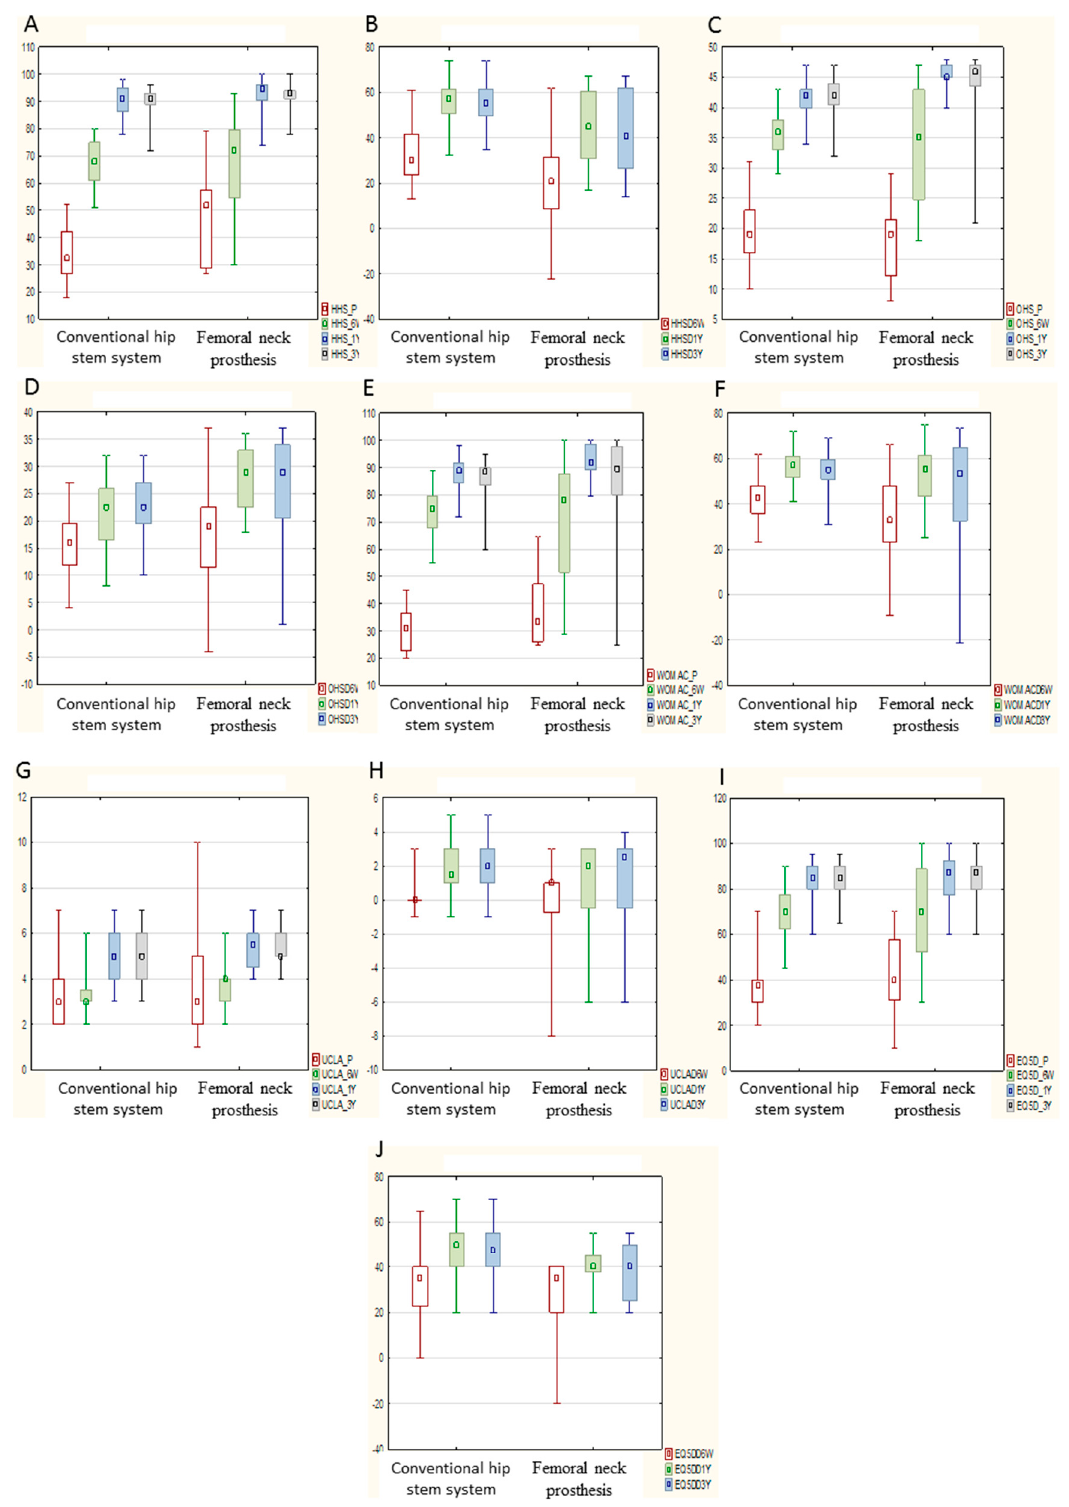
Figure 3. Box and whiskers plot graphs presenting median (point), quartiles (box), minimum and maximum (whiskers) in the functionality of the examined hips from HHS ( A ), HHSD ( B ), and various self-assessment forms: OHS ( C ), OHSD ( D ), WOMAC ( E ), WOMACD ( F ), UCLA ( G ), UCLAD ( H ), VAS EQ-5D ( I ), VAS EQ-5DD ( J ).